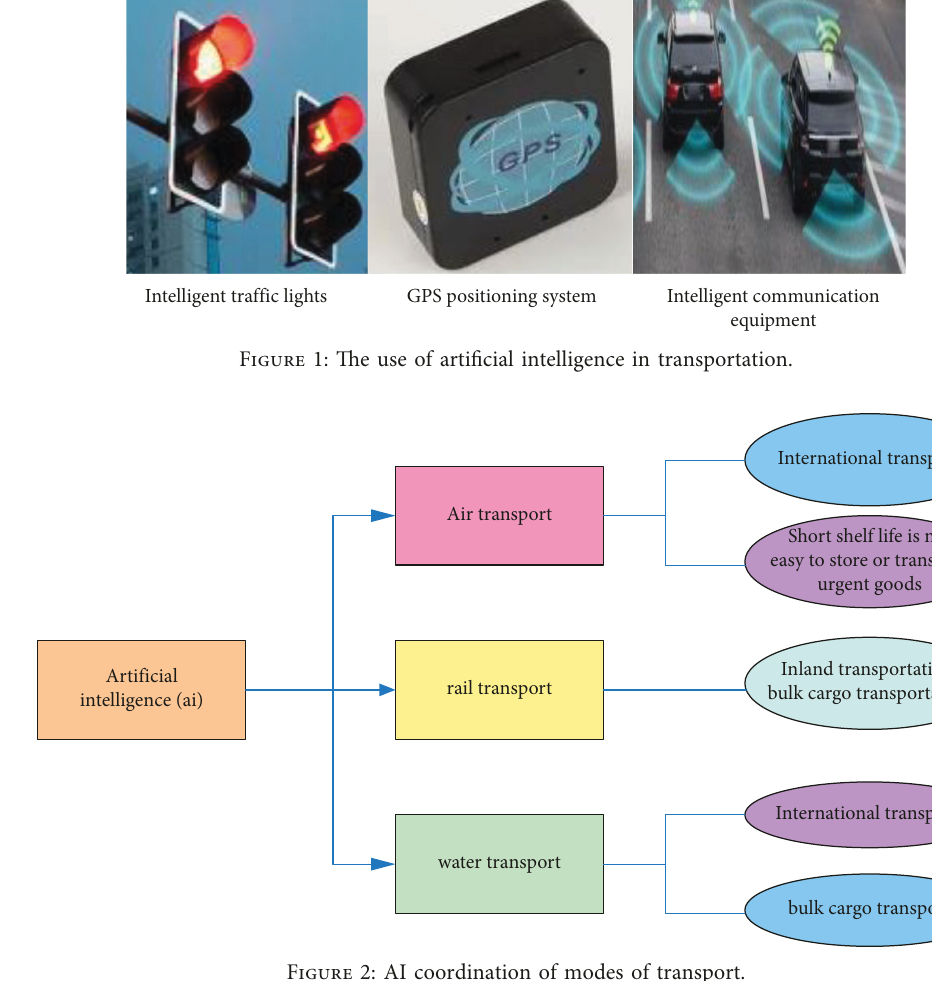
Figure 2: AI coordination of modes of